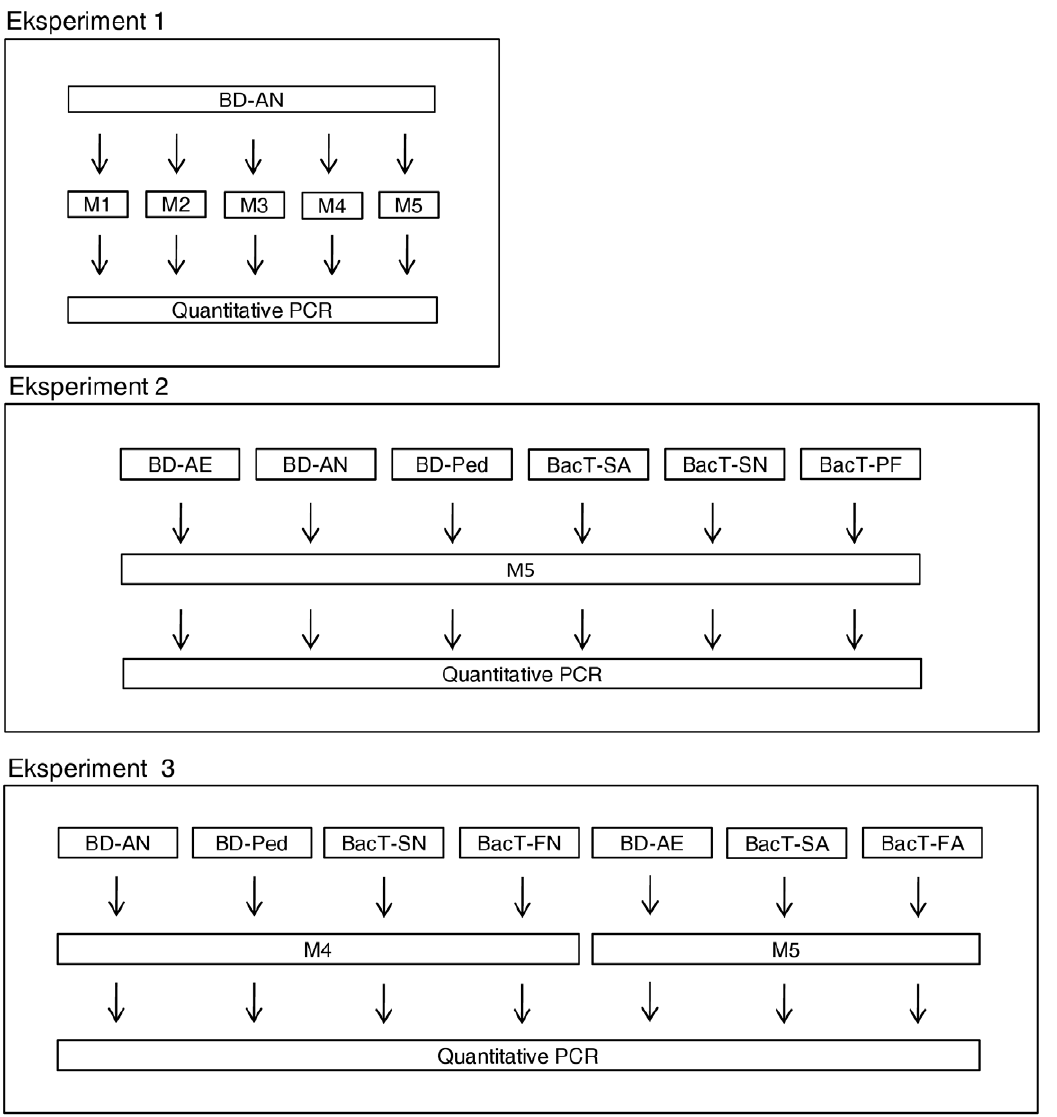
Figure 1. Flowchart for experiment 1–3. Figure shows flow over three independent experiments performed in the evaluation of five methods for DNA extraction from blood cultures media. BD-AE: BACTEC TM aerobic Plus, BD-AN: BACTEC TM anaerobic Plus, BD-Ped: BACTEC TM Paed Plus, BacT-SA: BacT/ALERT H SA, BacT-SN: BacT/ALERT H SN,BacT-PF: BacT/ALERT H PF, BacT-FA: BacT/ALERT H FA, BacT-FN: BacT/ALERT H FN. M1: Qiagen, DNeasy H Blood & Tissue Kit; M2: Molzym, MolYsis Plus Kit; M3: Protocol described by Fredricks and Relman; M4: Improved method for anaerobic and paediatric blood culture media; M5: Improved method adapted for all blood culture media.